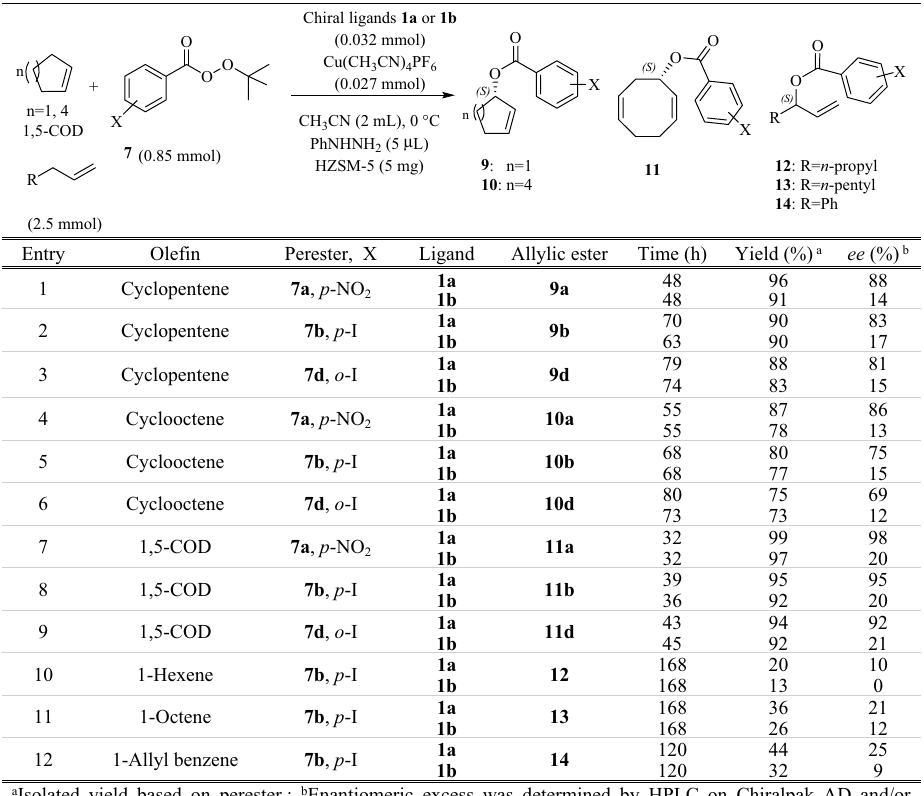
Table 2. Enantioselective allylic oxidation of cyclic and acyclic olefins using BOX ligands 1a and 1b.